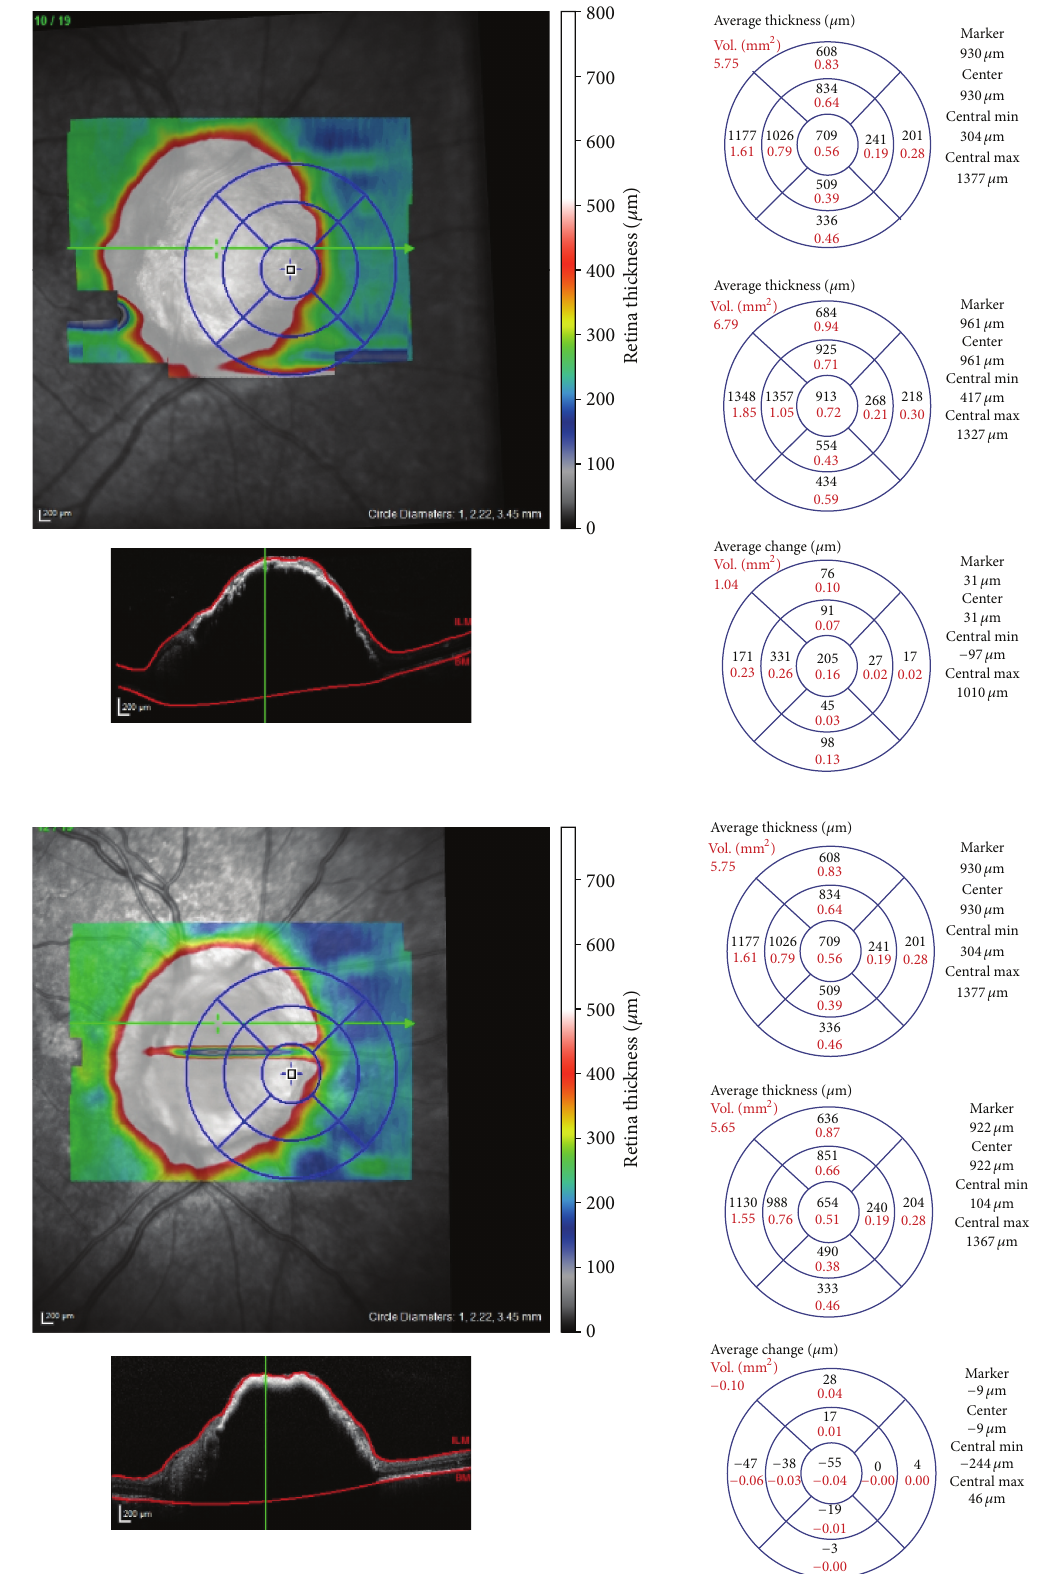
Figure 4: Thickness maps before and after